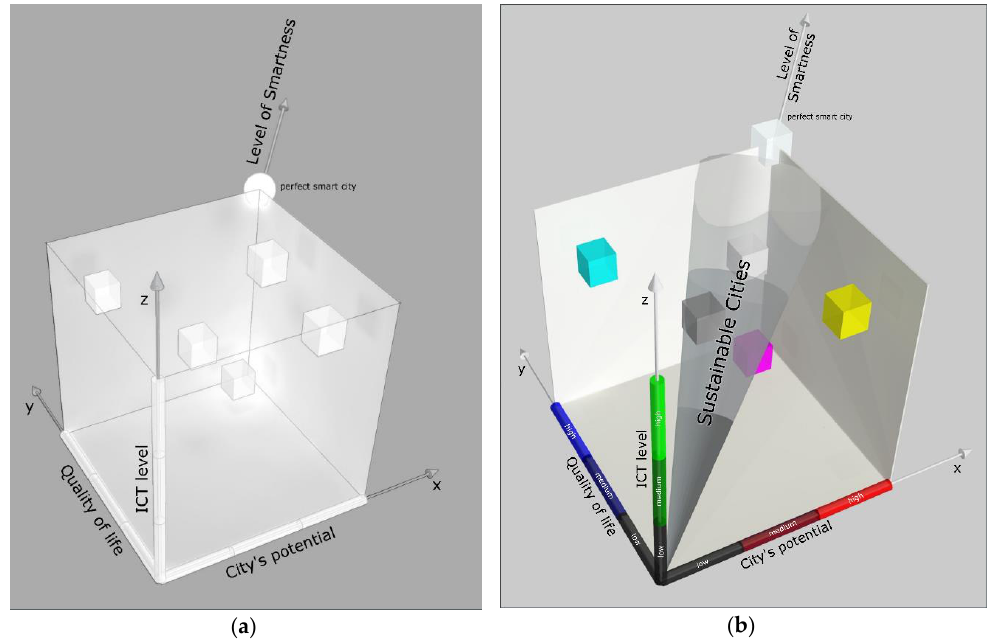
Figure 4. ( a ) Three-dimensional exemplary case. ( b ) Analogy of the RGB model. (x) City’s potential, Figure 4. (a ) Three-dimensional exemplary case. ( b ) Analogy of the RGB model. (x) City's potential, (y) quality of life, and (z) information and communication technology (ICT) (y) quality of life, and (z) information and communication technology (ICT) infrastructure.